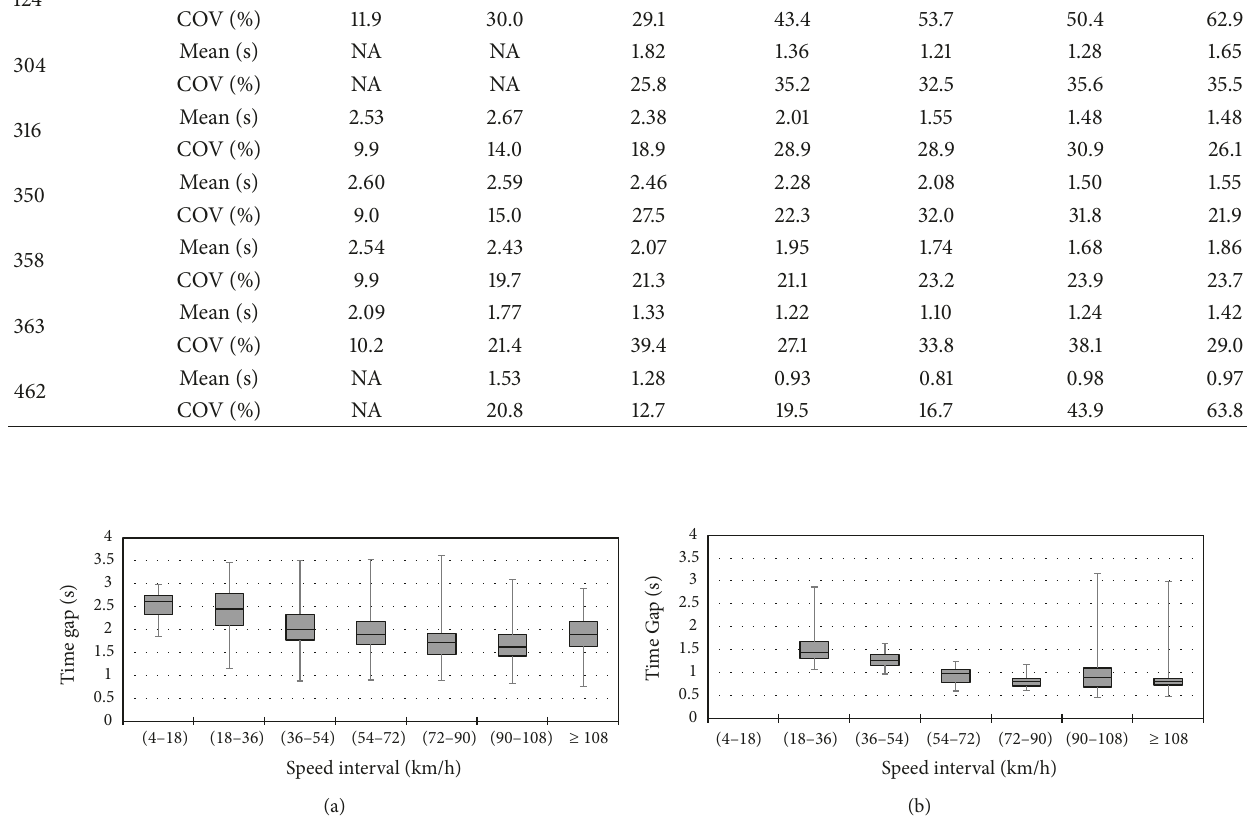
Figure 2: Box and whisker plots for time gap data for (a) Driver 358 and (b) Driver 462.